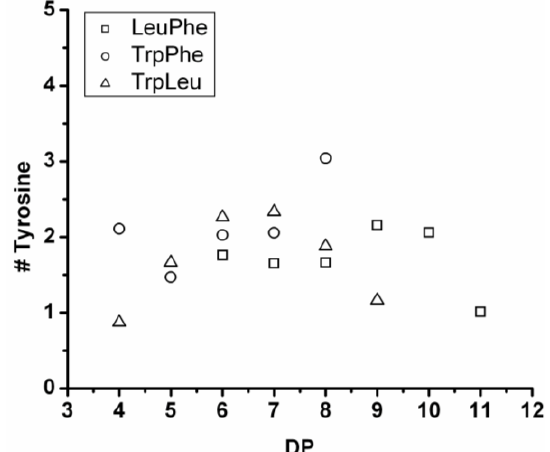
Figure 29. Average amount of tyrosine residues in ternary co-oligo amino